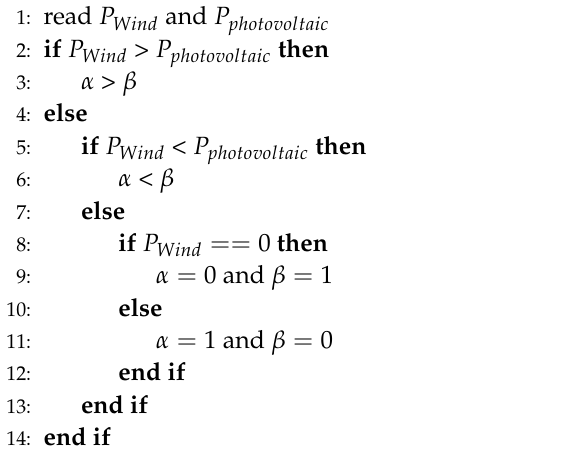
Algorithm 2 Pseudo code of ESA switching control behaviour (Period